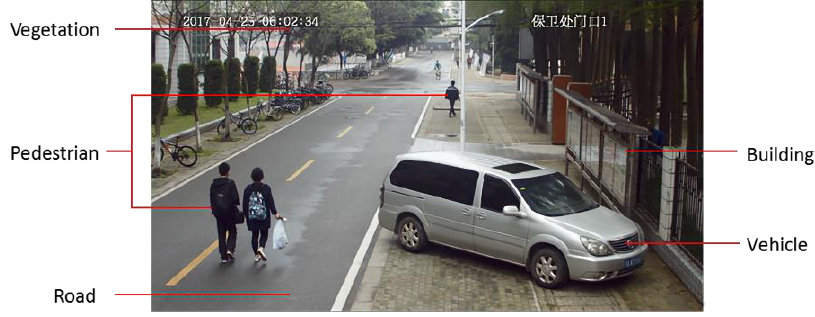
Figure 5. Surveillance video scene.